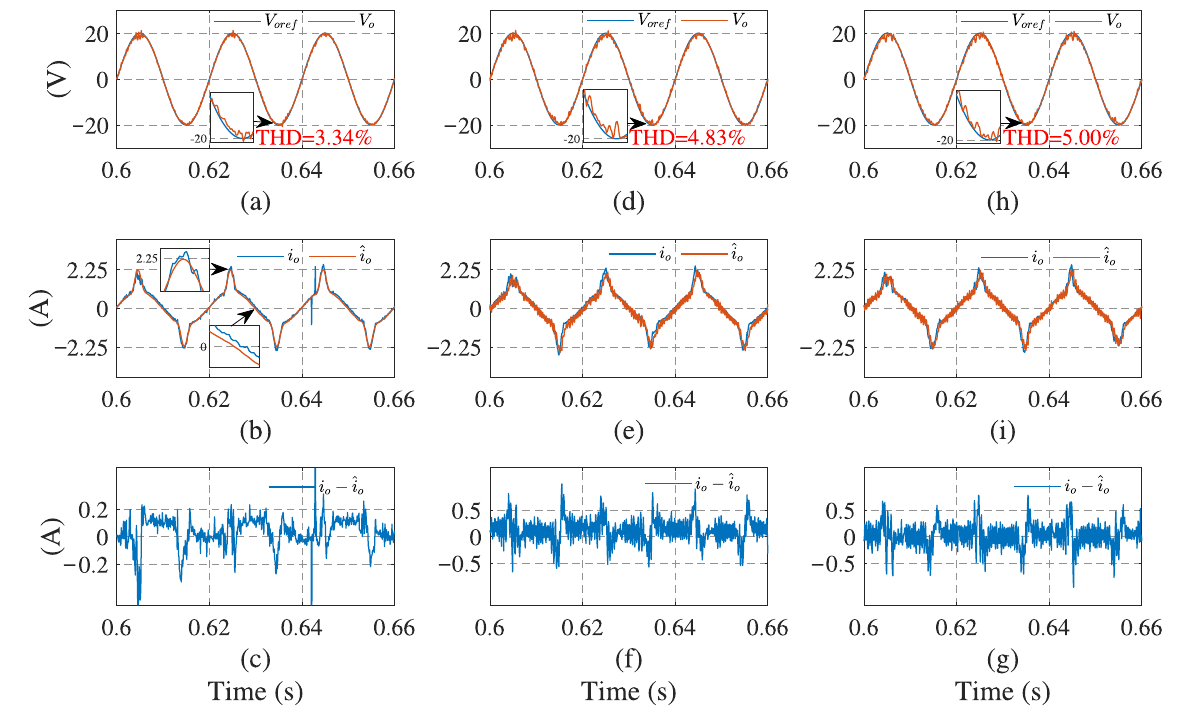
Figure 11. System experimental results using current estimation method under nonlinear load: ( a , d , h ) output voltage of observer, Kalman filter, and low-pass filter, respectively; ( b , e , i ) load currents of the three methods, respectively; ( c , f , g ) current estimation errors of the three methods, respectively. Table 3. Experimental result comparisons of the load current RMSE and output voltage THD under different